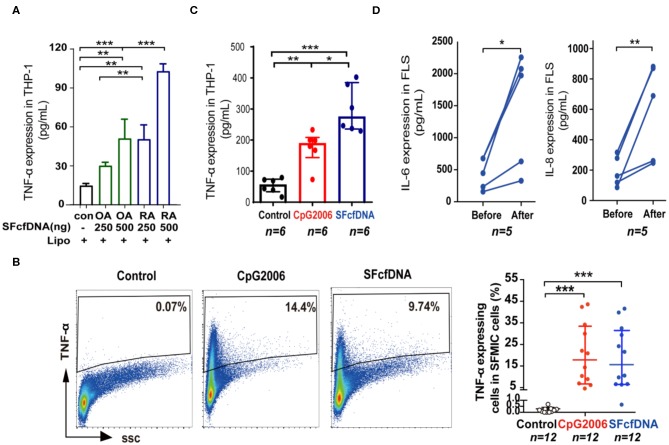
Cellular stimulatory function of SFcfDNA from RA patients. (A) Expression of TNF-α by THP-1 cells stimulated with SFcfDNA from OA or RA patients at two concentrations. The data shown are representative of three independent experiments with the same tendency. (B) The percentage of primary SFMICs from RA patients expressing intracellular TNF-α upon stimulation with SFcfDNA or CpG 2006. The data on the left is a representative sample and on the right is the mean of 12 samples. (C) TNF-α secretion by SFMICs (n = 6) stimulated with CpG 2006 or SFcfDNA (0.5 μg/2 × 105 cells) using the same procedure. (D) IL-6 and IL-8 expression on primary FLSs from RA patients (n = 5) stimulated with SFcfDNA from RA patients. Statistical significance was calculated by one-way ANOVA (A), Kruskal–Wallis Dunn's multiple comparison test (B,C), two-tailed paired T testing (D). *0.01 < P < 0.05, **0.001 < P < 0.01, ***P < 0.001. Data are presented as the mean with SD (A), and (B,C) data are presented as the median with interquartile range.